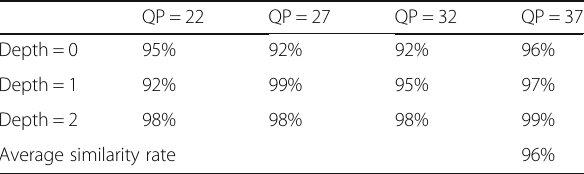
Table 2 Comparison of the division of threshold β and HM